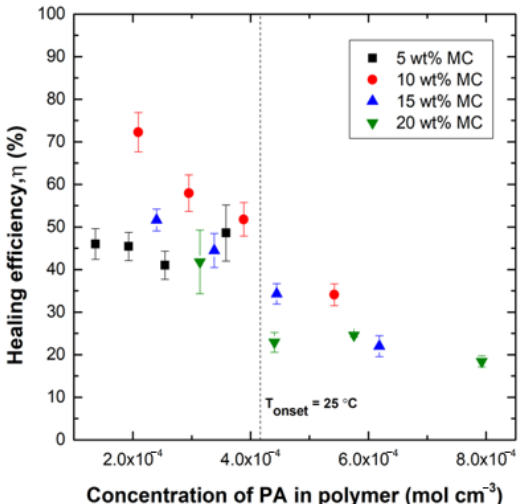
Figure 11. Healing efficiency, η, vs. concentration of PA in the polymer as calculated by the analytical model for specimena with varying microcapsule content at varied healing times (2, 4, 7, and 14 days). The concentration needed for T onset = 25 °C is plotted to differentiate which specimens are affected by plasticization.